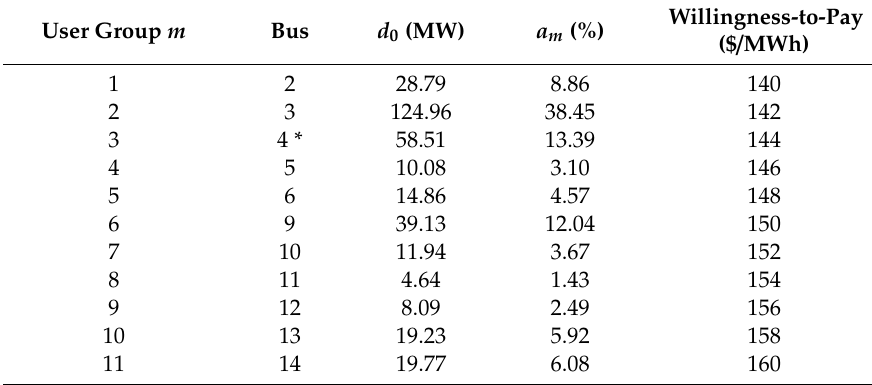
Table 2. Parameters of